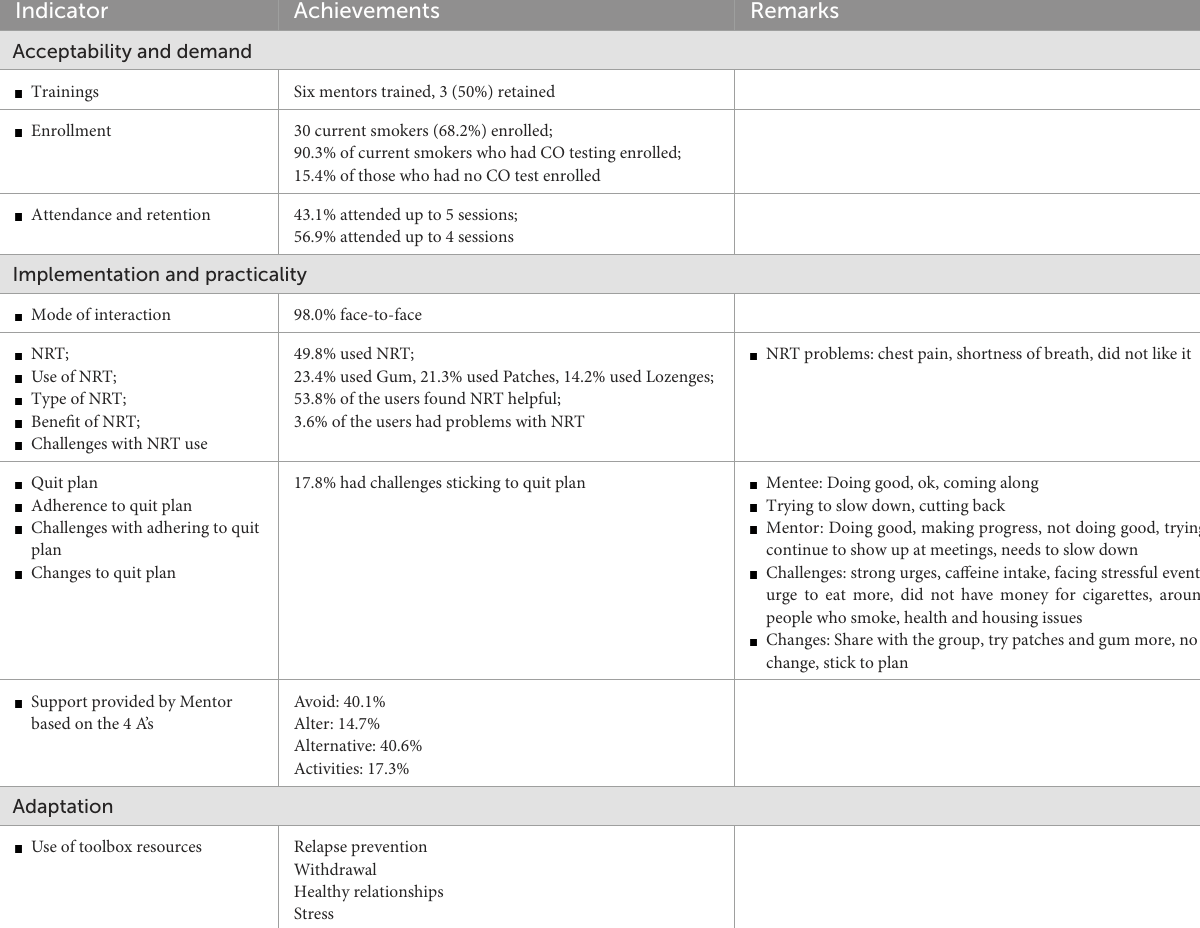
TABLE 5 Assessing feasibility of implementation. Indicator